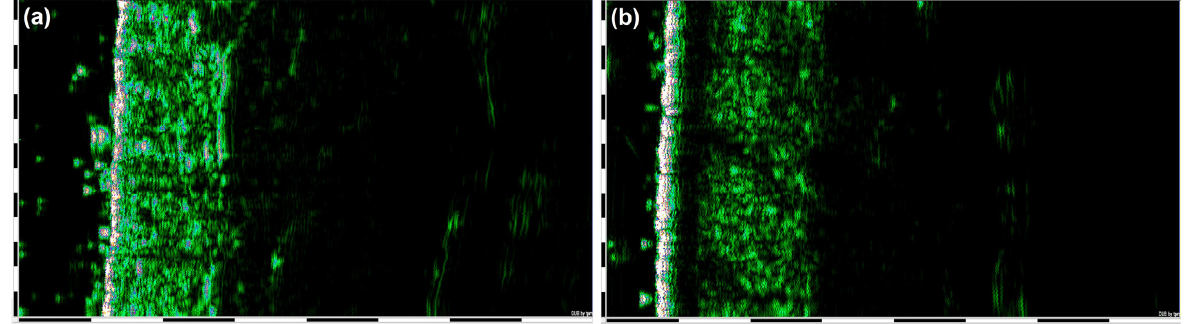
Figure 1. HFU of the skin without psoriatic plaques ( a ) and skin covered with psoriatic plaques ( b ). Epidermal proliferation is disturbed during the course of psoriasis. The passage time of keratinocytes from the basal layer to the stratum corneum is reduced eightfold. Physiologically, this process takes 30 days, and in patients with psoriasis it is shortened to 3–6 days [7–9]. The effect of the accelerated migration of keratinocytes is parakeratosis, which is the presence of nuclei in the cells of the stratum corneum. The pathomorphological image also shows agranulosis (atrophy of the granular layer), acanthosis (hypertrophy of the spinous layer) and papillomatosis (elongation of epidermal icicles). In addition, inflammatory cells are infiltrated and Munro micro-nodes are formed [5,10].